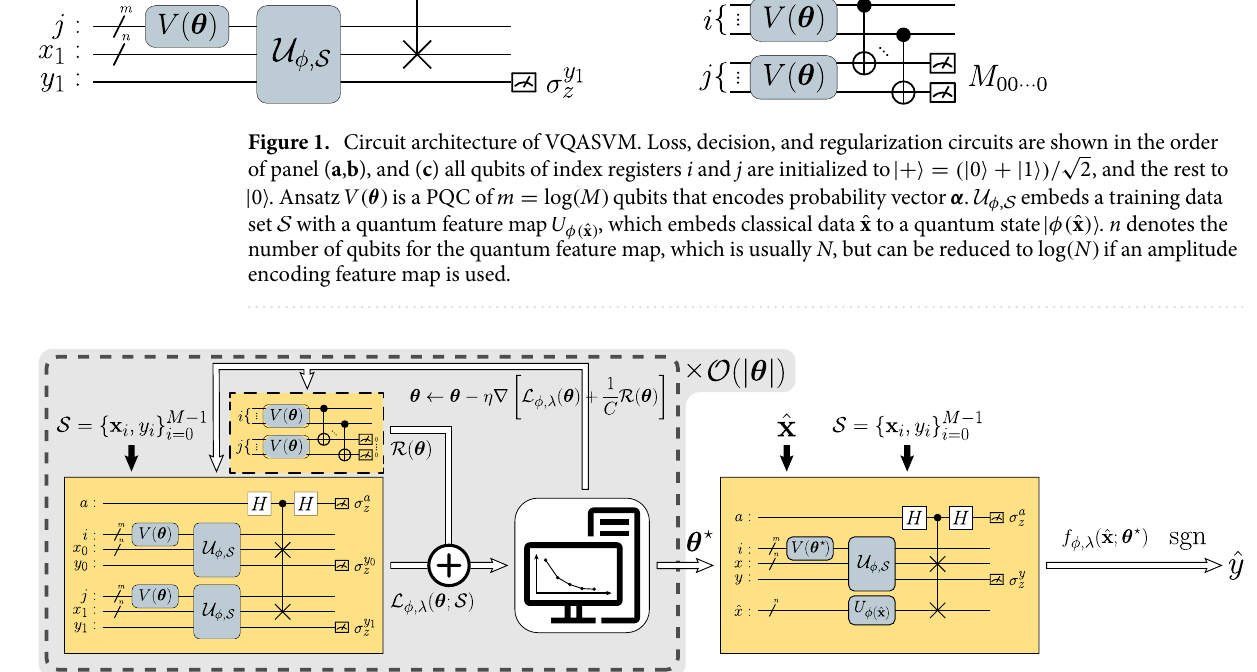
log ( M ) qubits that encodes probability vector α . U φ , S embeds a training data = x ) , which embeds classical data ˆ